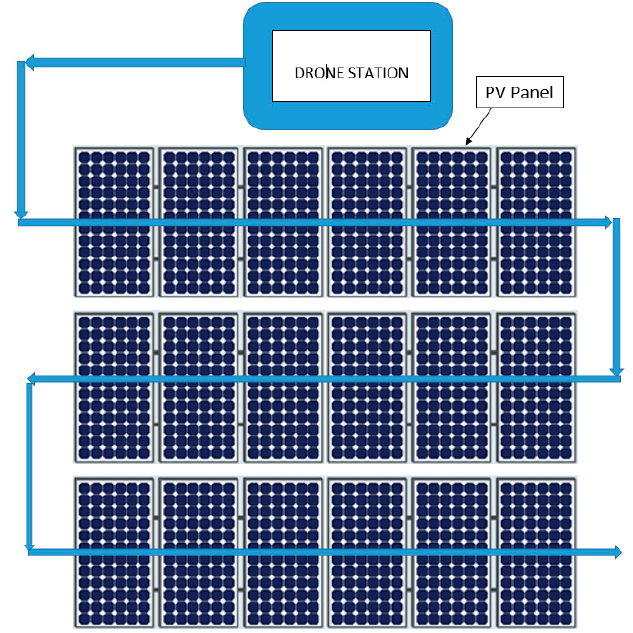
Figure 9. Drone route for the horizontal PV panels cleaning pattern.